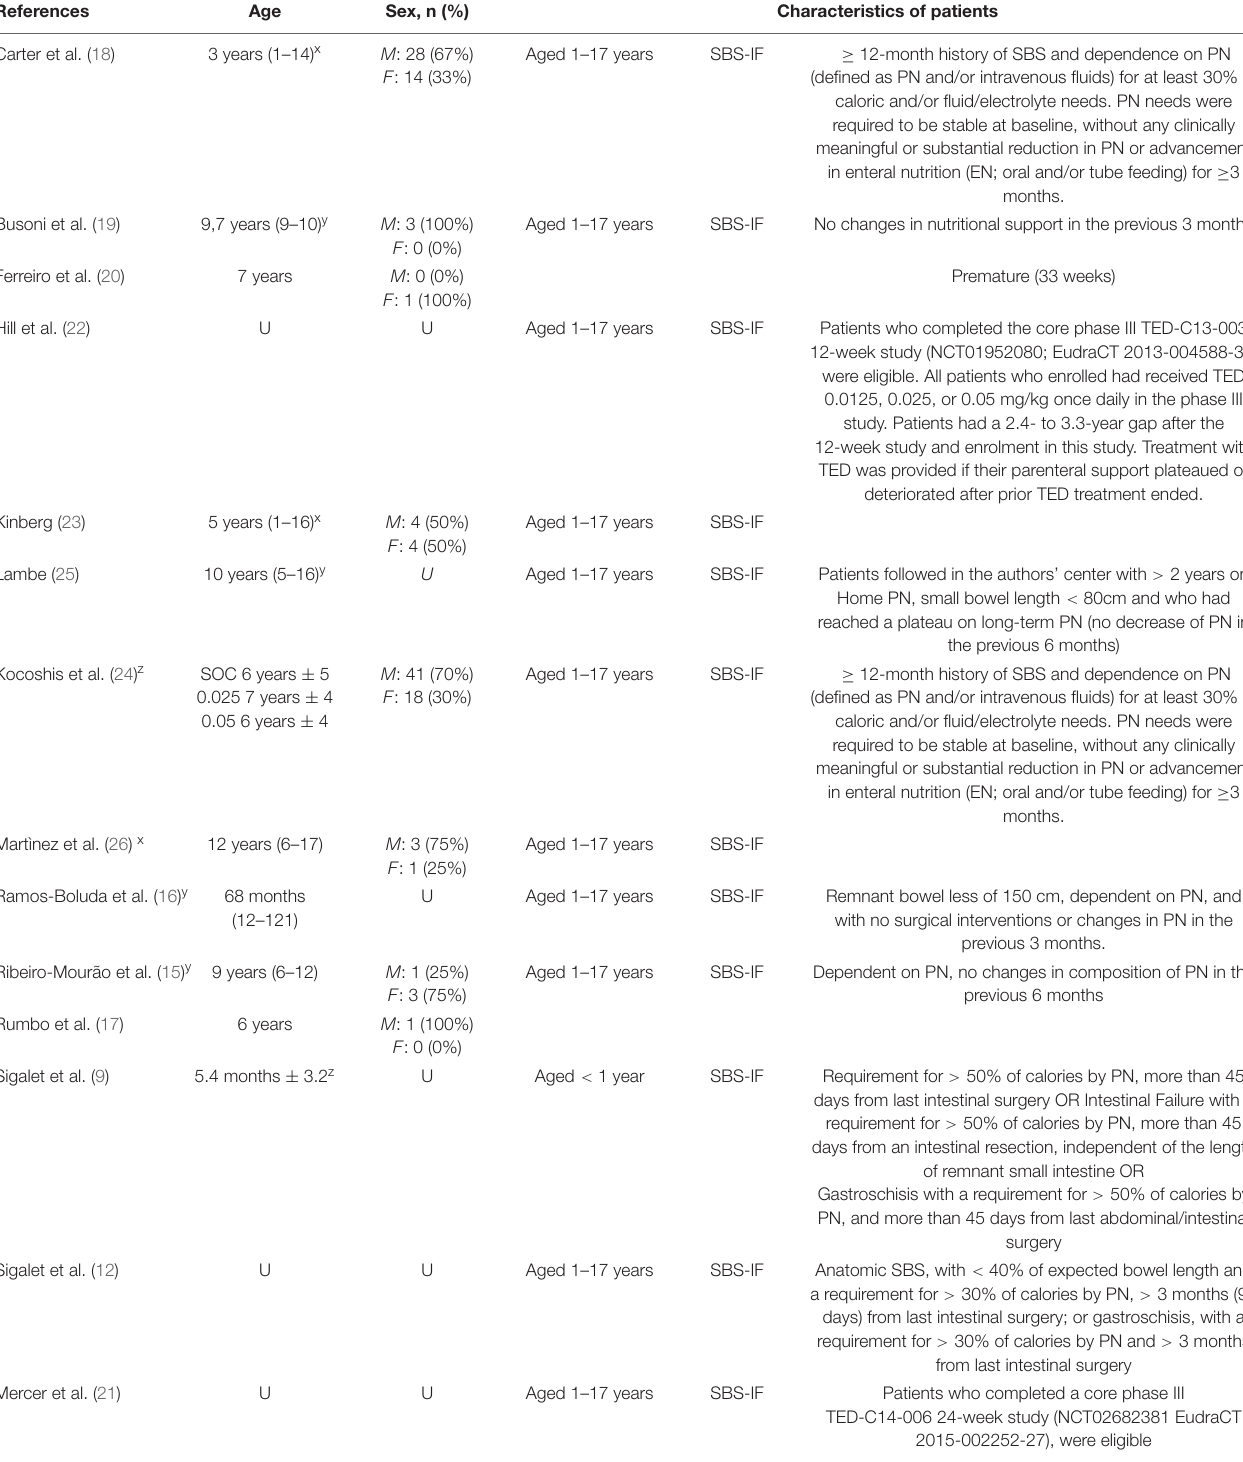
TABLE 2 | Characteristics of